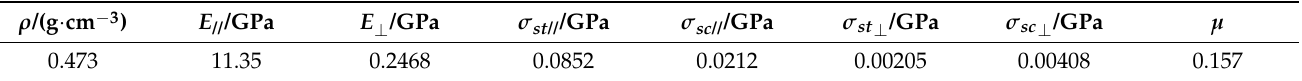
Table 2. Wood material parameters.